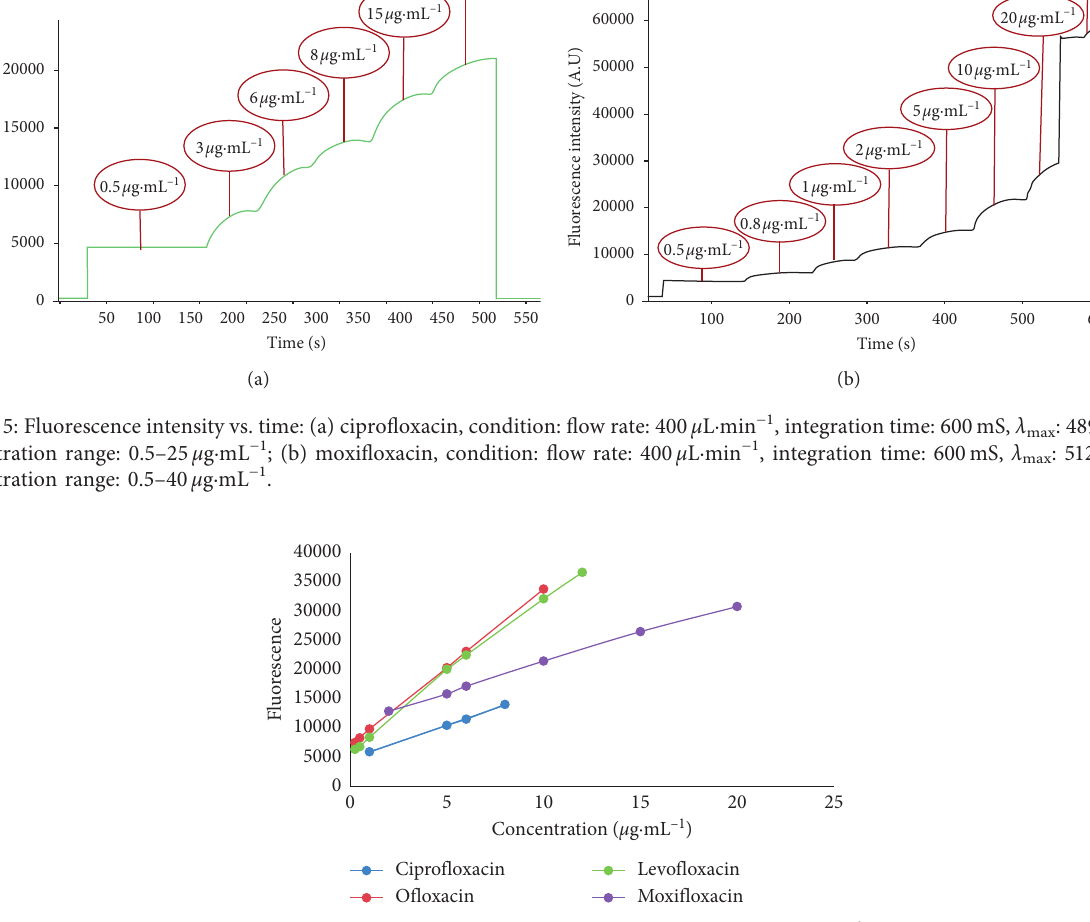
Figure 6: Calibration curve of standard fluoroquinolones. Condition: flow rate, 400 μ L · min − 1 ; integration time: